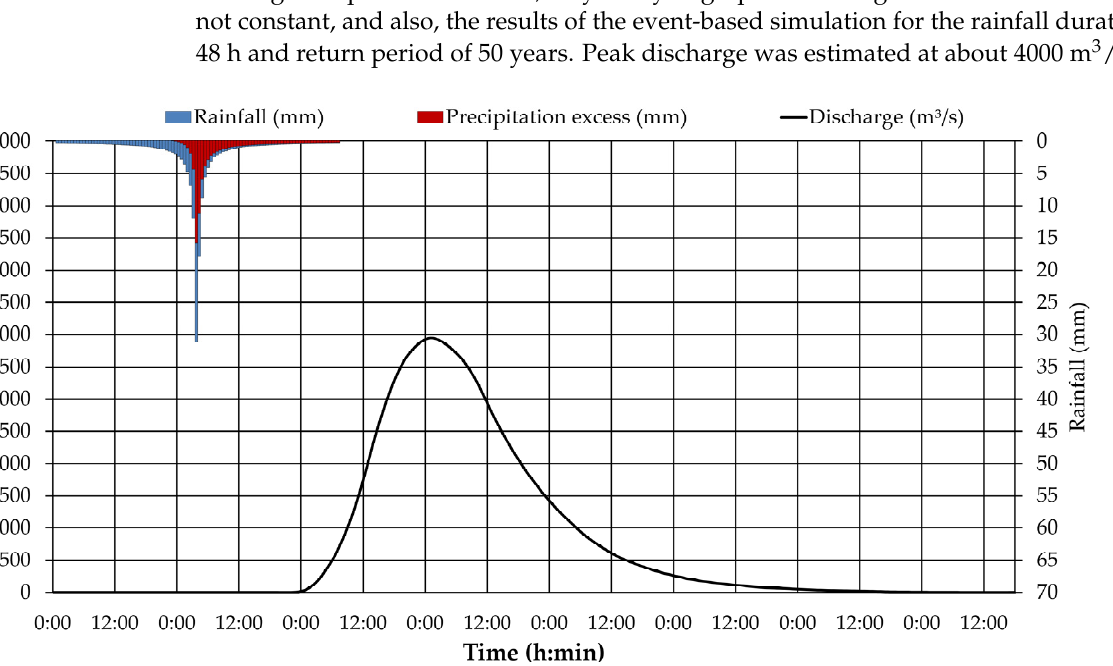
Figure 5. Continuous simulation results from 1 January 1998 to 31 December 2019. Flood frequency analysis was undertaken for the annual maxima series of synthetic peak discharges using Extreme Value Type I (Gumbel) and GEV probability distributions. For assessing the fitting of both probability distributions to the annual maxima series of synthetic peak discharges, the Kolmogorov–Smirnov and chi-squared statistical tests were performed for various significance levels (1%, 5% and 10%). For both distributions and for both statistical tests, it was concluded that both Gumbel and GEV probability distri- butions can be used for modeling annual maxima flood peaks. Table 5 presents the sample statistics for the annual maxima series of synthetic peak discharges. Finally, Figure 6 presents the fitting of the theoretical distributions (Gumbel and GEV) to the empirical ones. The Weibull plotting position was used for estimating empir- ical quantiles. It can be observed that both Gumbel and GEV distributions describe the